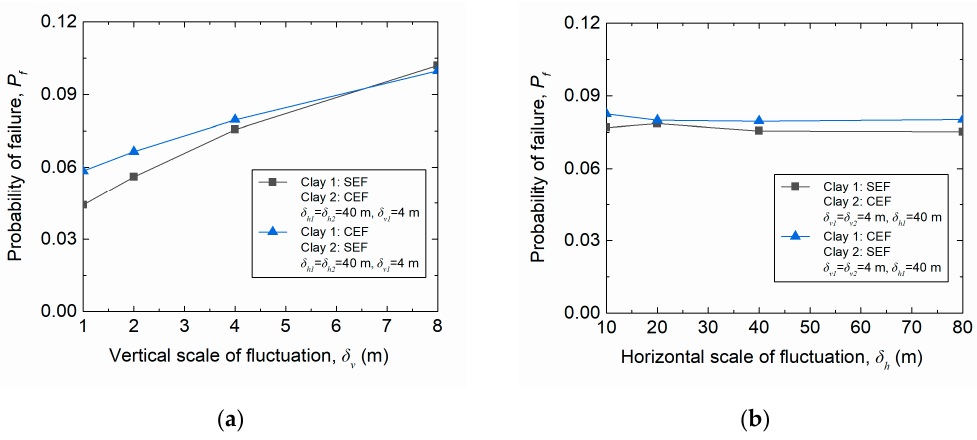
Figure 9. Influence of SOFs in the upper stratum on slope failure probability: ( a ) Slope failure probability versus δ v 2 ; ( b ) Slope failure probability versus δ h 2 .